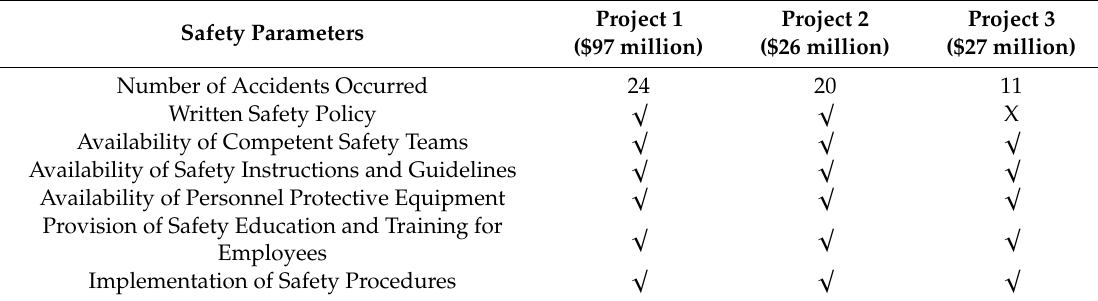
Table 1. Key safety parameters of sample